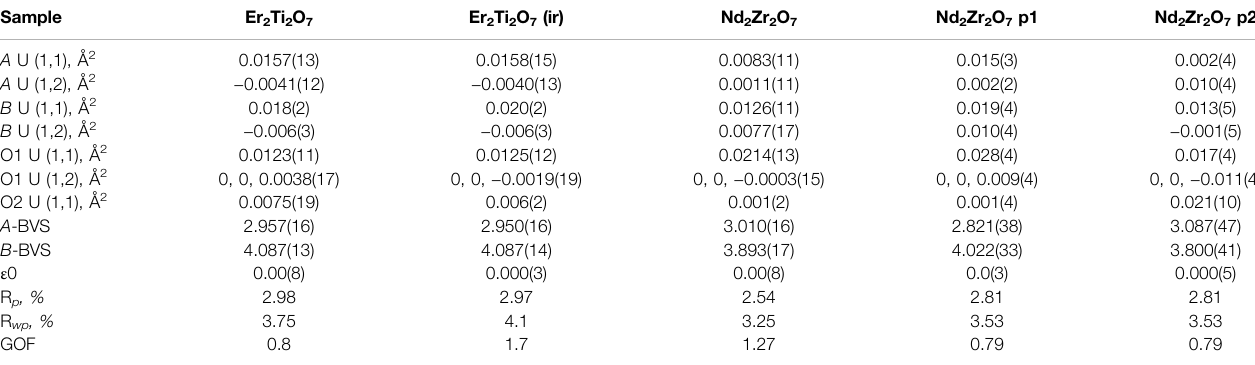
TABLE 3 | Re fi ned parameters where A U (1,1) and A U (1,2) are the anisotropic displacement parameters of the A cation , B U (1,1) and B U (1,2) are the anisotropic displacement parameters of the B cation , O1 U (1,1) and O1 U (1,2) are the anisotropic displacement parameters of the oxygen at the O1 position, O2 U (1,1) is the anisotropicdisplacementparameteroftheoxygenattheO2position, A -BVSisthebondvalencesumoftheAcation, B -BVSisthebondvalencesumoftheBcation, ε 0isthe calculated strain, R p isthe R-pattern (background corrected), R wp isthe R-weighted pattern(background corrected), and GOF isthe goodness of fi tfor the unirradiated and irradiated Er 2 Ti 2 O 7 and Nd 2 Zr 2 O 7